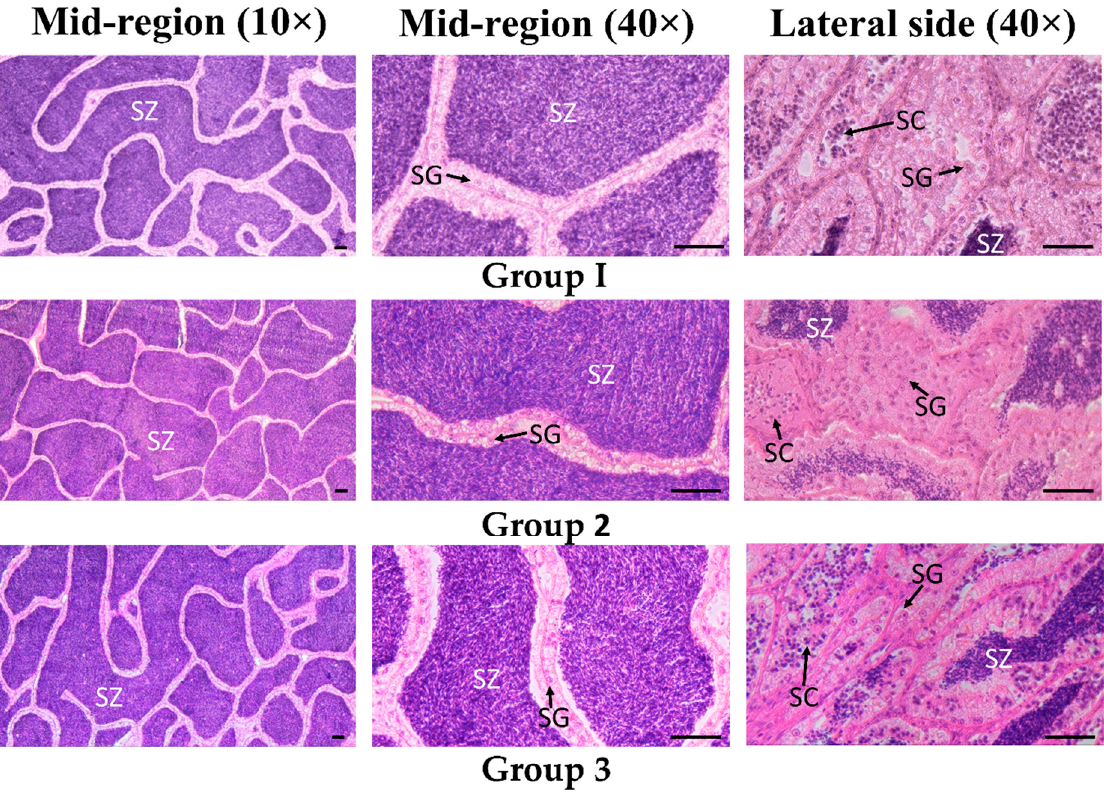
Figure 7. Light micrographs of testis sections in different fish groups. Group OW—fish were held in fish-farming ponds (water temperature 2 °C); group ST—fish were adapted to spawning temperature of 14 °C, spermiation was not induced; group ST-HI—fish were adapted to spawning temperature of 14 °C, spermiation was induced. SC—spermatocytes; SG— spermatogonia; SZ—spermatozoa. Mid-region (10×)—predominant images of the mid-regions of the testis, magnification 10×; mid-region (40×)—predominant images of the mid-regions of the testis, magnification 40×; lateral side (40×)—images of the lateral side of the testis, magnification 40×. Scale = 50 μ m.